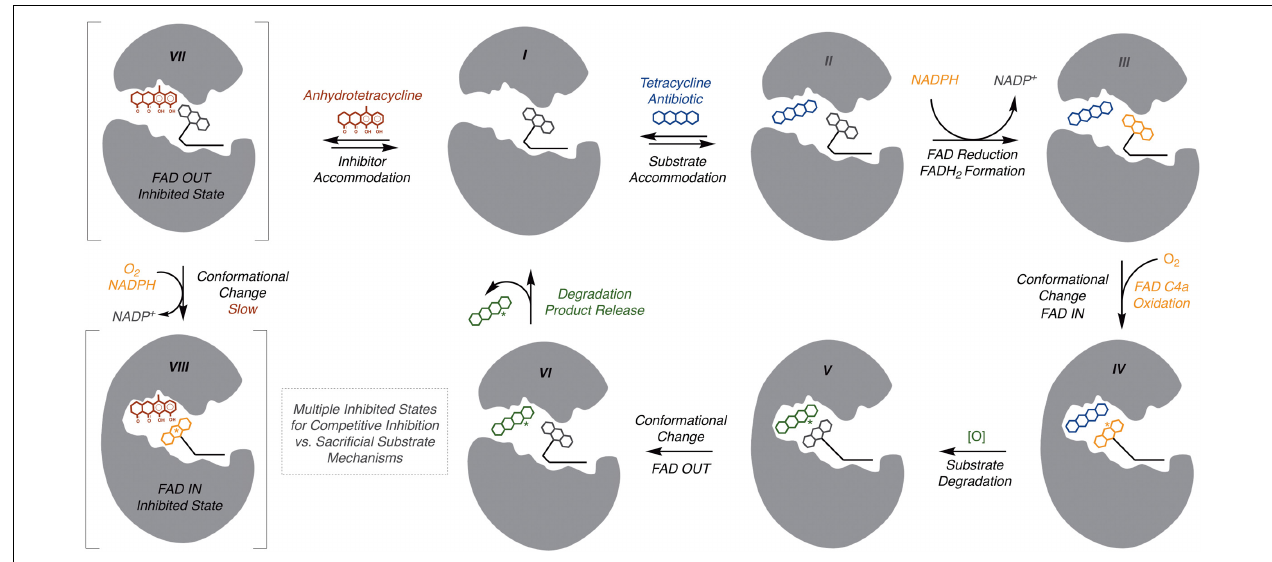
FIGURE 13 | A mechanistic model for the tetracycline destructase catalytic cycle and inhibition by anhydrotetracycline is proposed. (I) Flavin oxidized, open active site; (II) substrate binding, flavin oxidized, open active site; (III) substrate bound, flavin reduced, open active site; (IV) substrate bound with C4a-peroxyflavin in “in” conformation, closed active site; (V) oxidized product bound with C4a-hydroxyflavin in “in” conformation, closed active site; (VI) substrate bound with C4a-hydroxyflavin in “out” conformation, open active site; (VII) inhibitor bound with flavin in “out” conformation, open active site; (VIII) inhibitor bound with C4a-peroxyflavin in “in” conformation, closed active